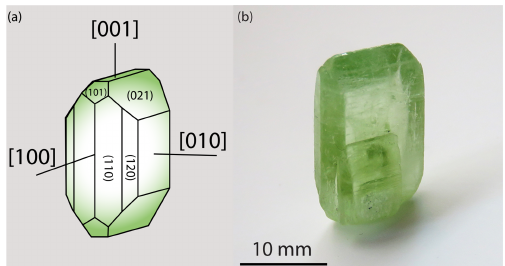
Figure 1. The habit and main crystallographic directions of olivine: (a) theoretical model and (b) automorphic hydrothermal olivine from Sapat,